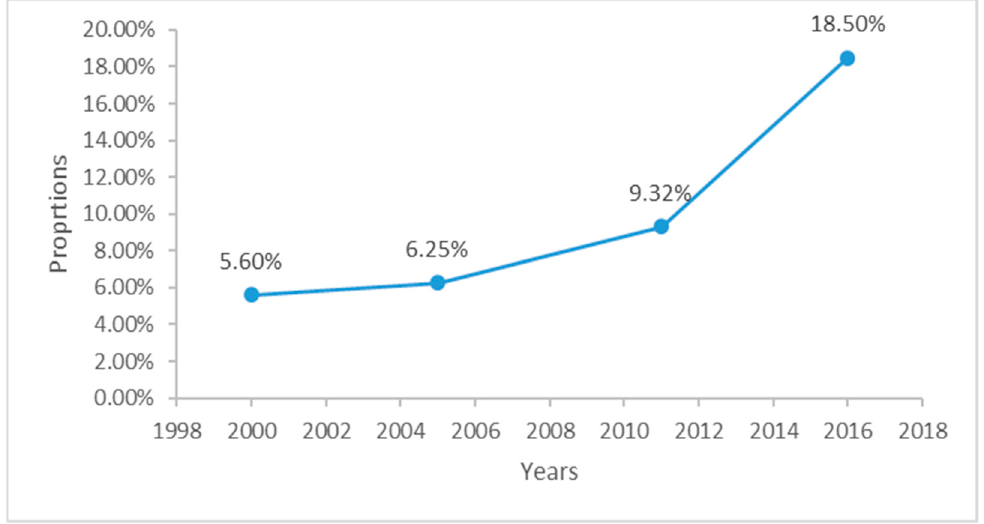
Figure 2. Trends of postnatal care (PNC) utilisation in Ethiopia (EDHS) 2000–2016.